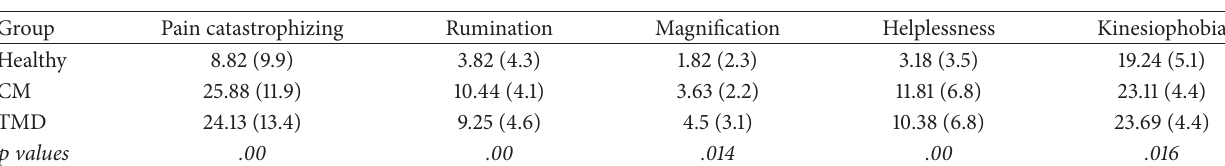
Table 2: (a) Mean comparison (standard deviation) between groups for pain catastrophizing scale (PCS) with subscales and kinesiophobia. (b) Mean difference between groups for pain catastrophizing scale (PCS) with subscales and kinesiophobia.